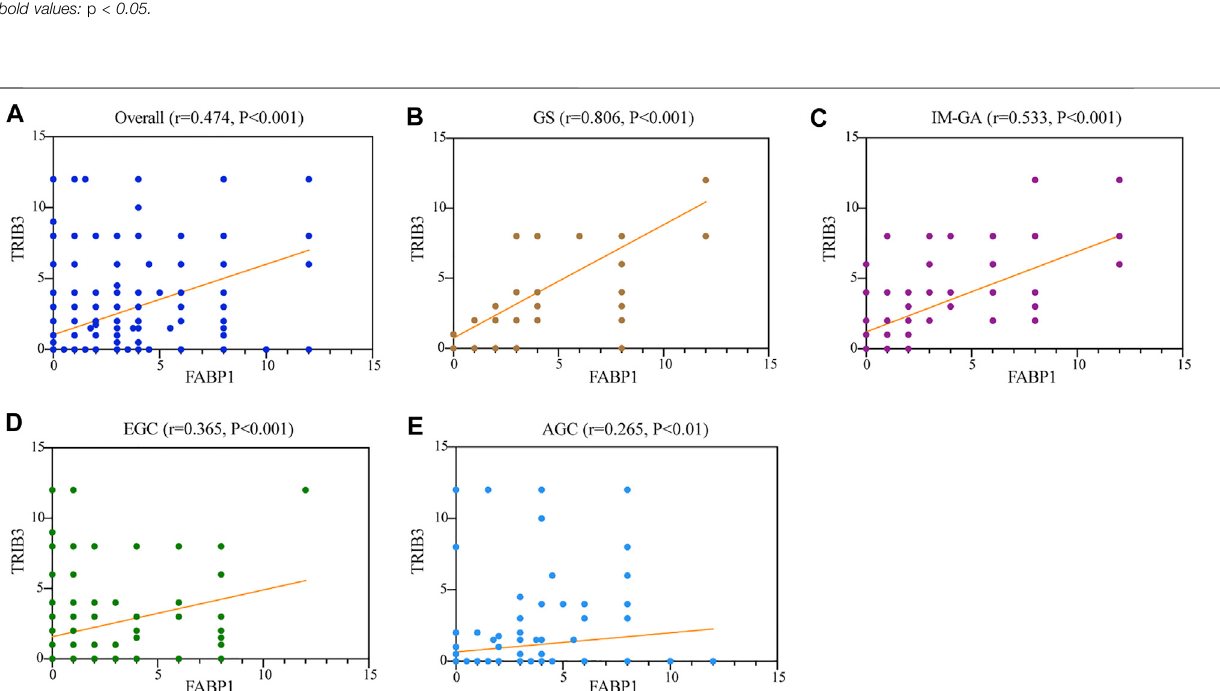
Frontiers in Molecular Biosciences |